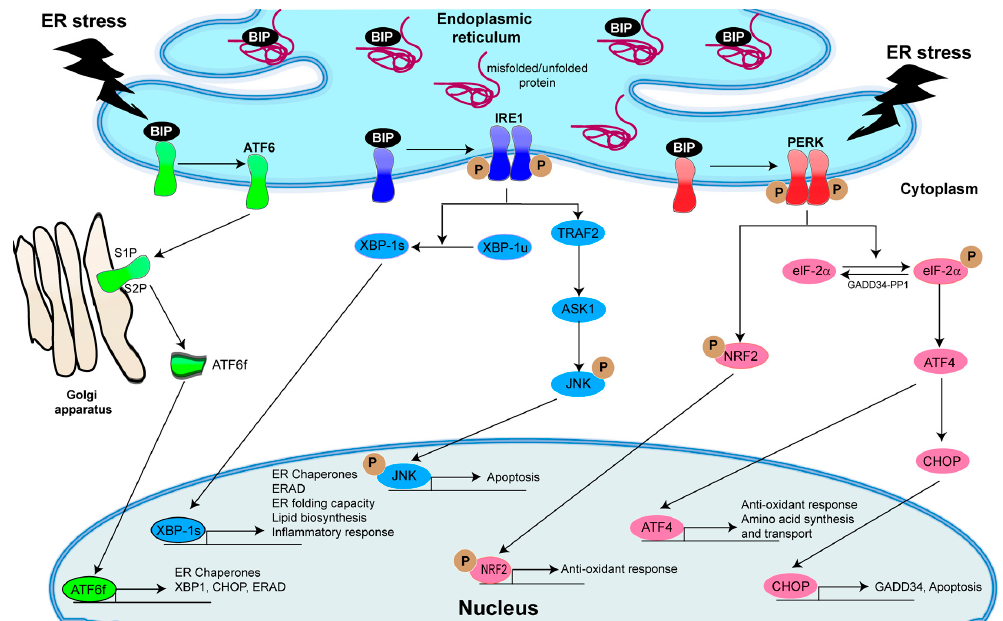
Figure 1. Unfolded protein response (UPR) pathways in mammalian cells. Under non endoplasmic reticulum (ER) stress conditions, BIP (immunoglobulin binding protein) is bound to the ER